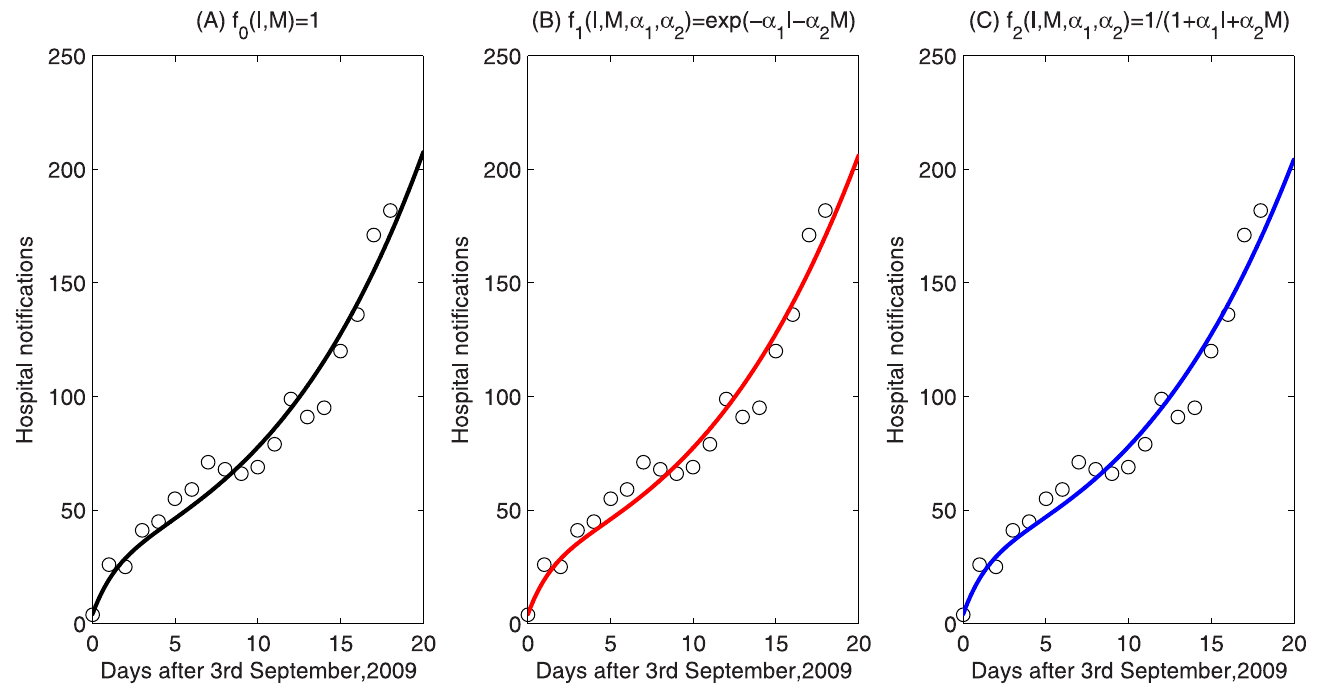
Fig 1. Data fitting for the daily number of hospital notifications from September 3rd to 21st, 2009 in the 8th hospital of Xi’an. Circles represent the hospital notifications in the 8th hospital of Xi’an, black curve, red curve and blue curve represent the estimating solutions for the number of infected individuals in system (1) without media impact (i.e. f 0 = 1), and by using media function f 1 = e − α 1 I − α 2 M , f 2